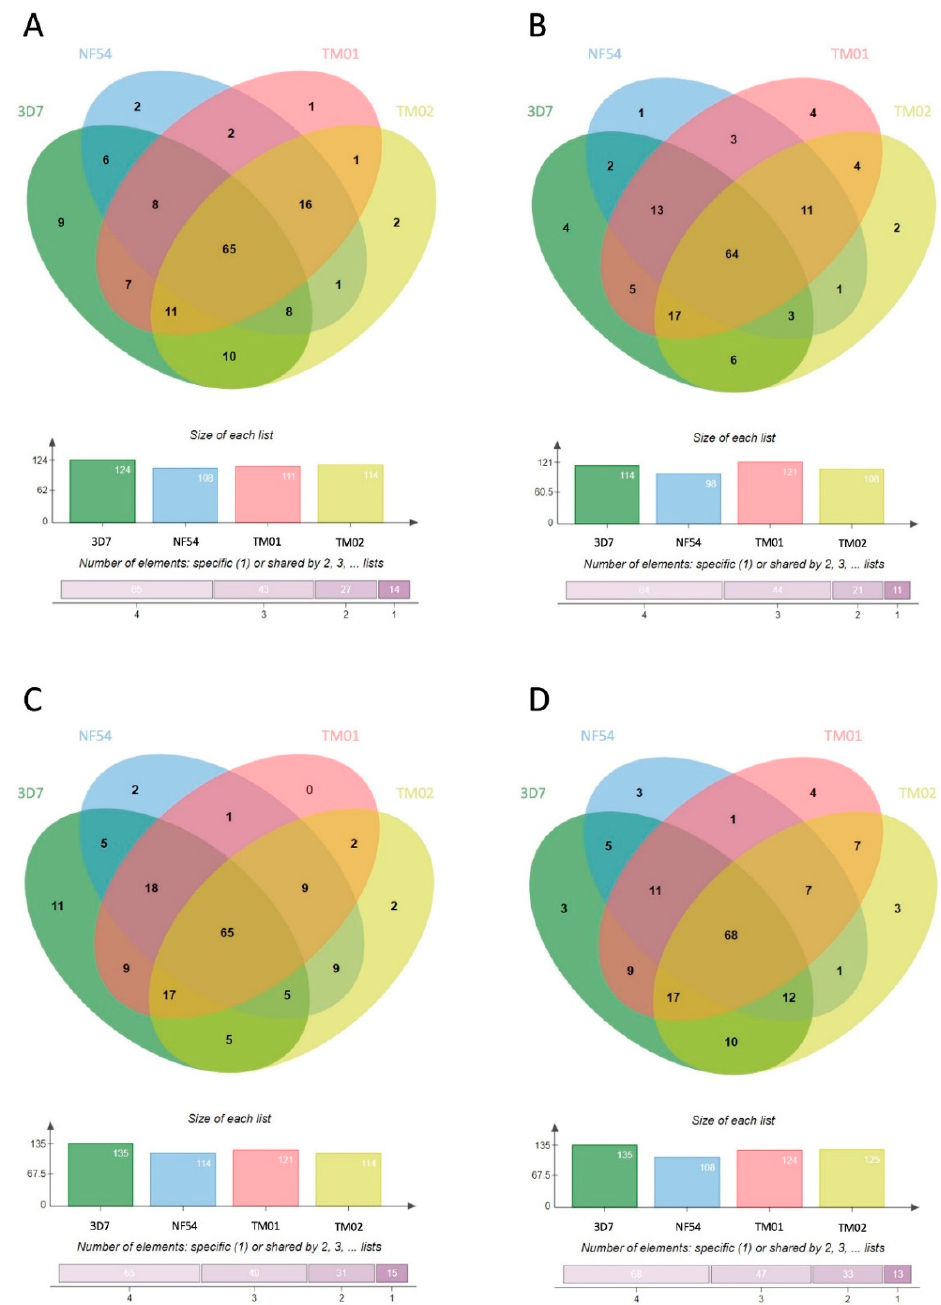
Figure 3. Venn diagrams showing the human proteins differentially found in each type of Pf -EVs from 4 P. falciparum strains (3D7, NF54, TM01, and TM02). ( A ) MV-E, n = 149; ( B ) MV-L, n = 140; ( C ) Exo-E, n = 160; ( D ) Exo-L, n = 161. The column graph presents the number of proteins in each strain of P. falciparum, and the bar graph indicates the cumulative number of proteins shared among the P. falciparum strains.